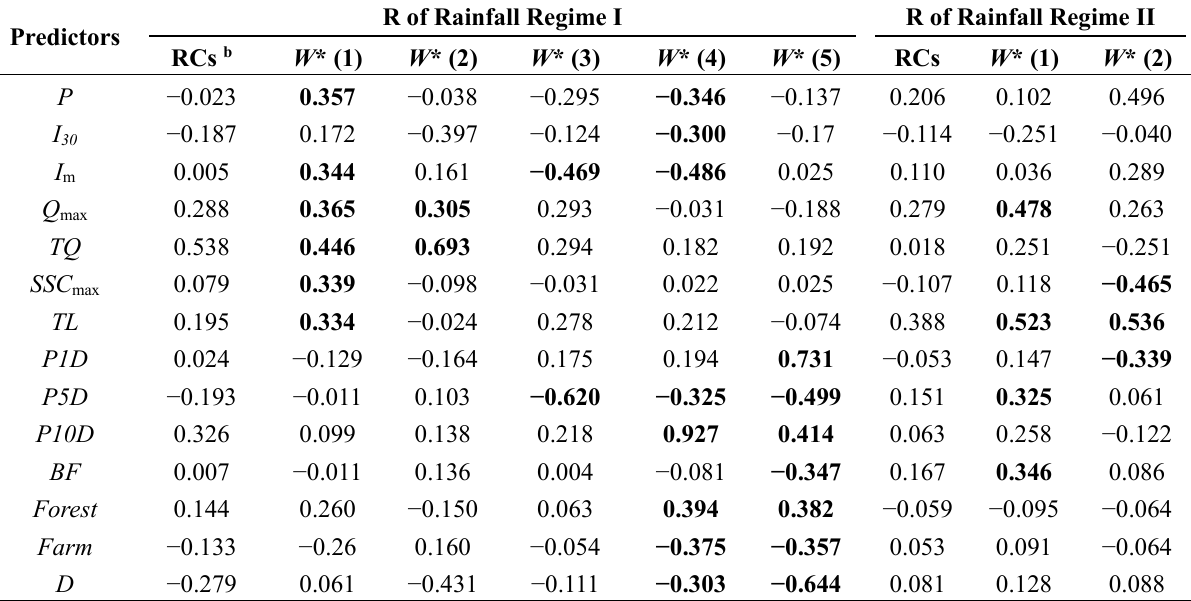
Table 6. PLSR for runoff a